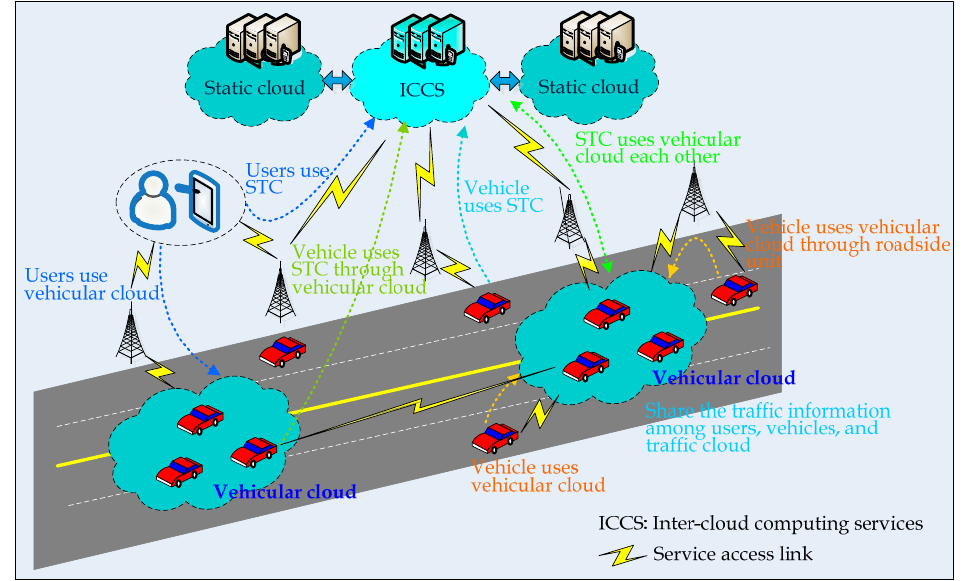
Figure 1. Information interaction for VWC.